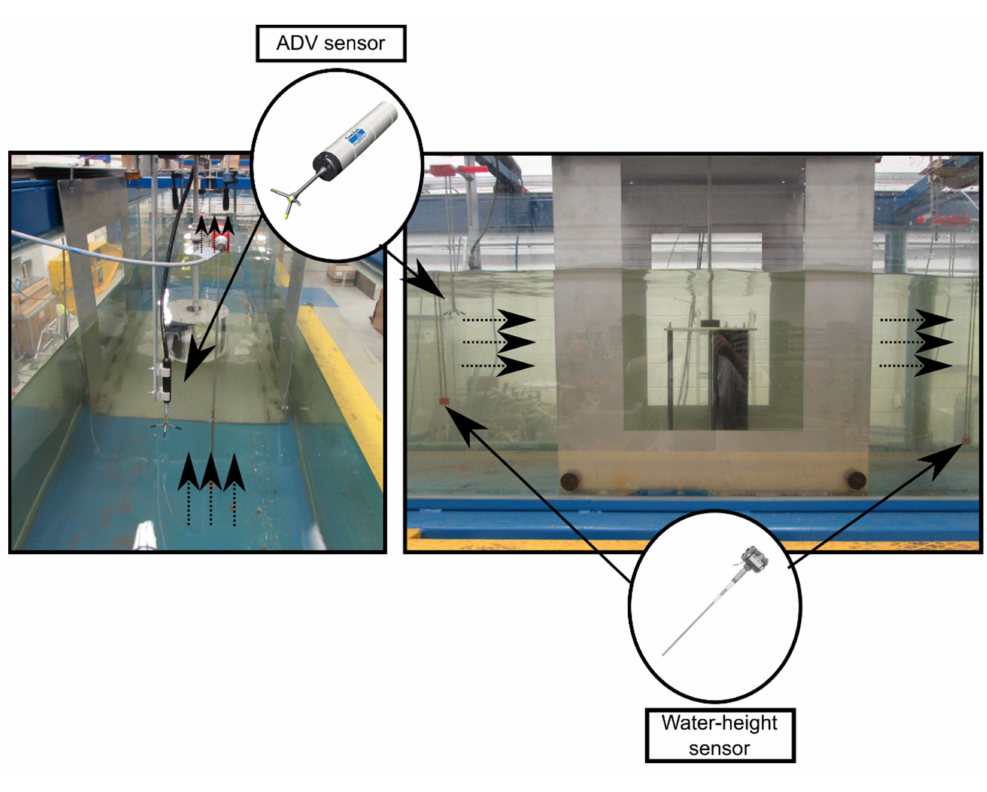
Figure 5. Hydraulic sensors’ locations during tests.